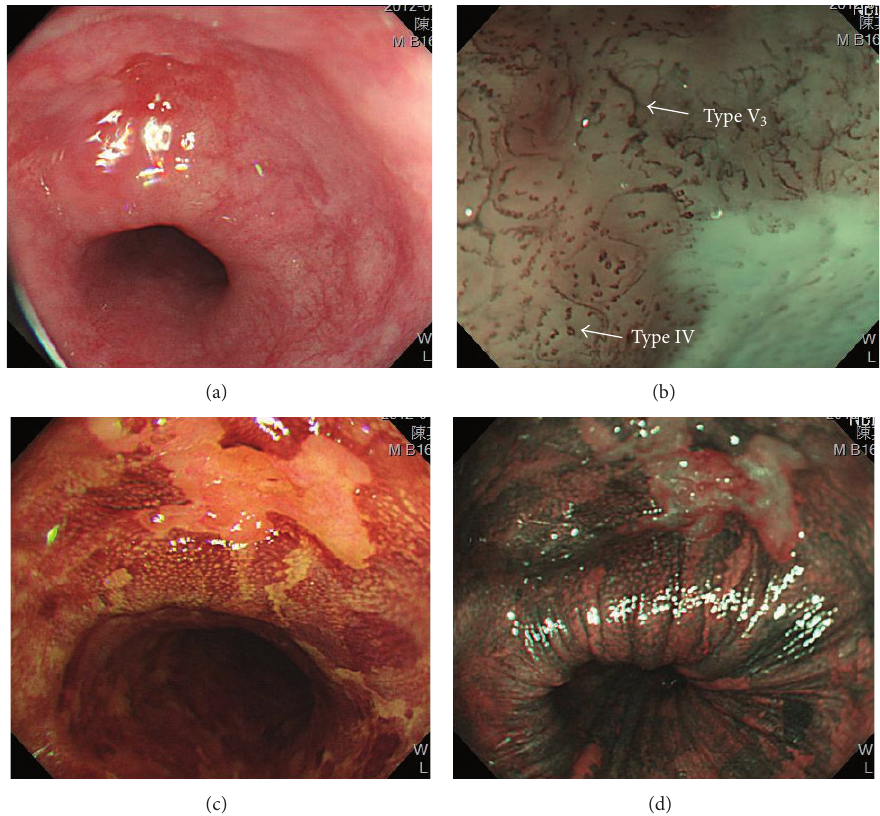
Figure 3: (a) Conventional white-light imaging endoscopy shows a type 0-IIc hyperemic lesion of esophagus. (b) Magnifying endoscopy with narrow-band imaging system reveals abnormal intraepithelial papillary capillary loops (Inoue’s classification type IV to V 3 ). (c) and (d) Chromoendoscopy with 1.5% Lugol’s solution discloses Lugol-unstained area which appears pinkish under white-light imaging and silver pattern under narrow-band imaging 3 minutes after spraying